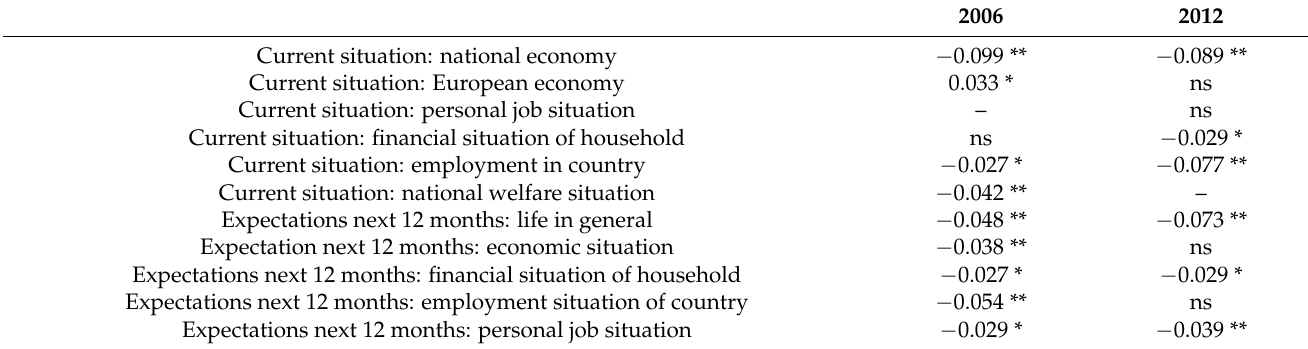
Table 4. Aggregate non-parametric correlations (tau-b) between economic perceptions and attachment to the country. Current situation: 1—very bad, 2—rather bad, 3—rather good, 4—very good. Expectations: 1—worse, 2—same, 3—better. Source is authors’ own elaboration based on Eurobarometer 65.2 and 77.3. p values: * ≤ 0.05, ** ≤ 0.01.